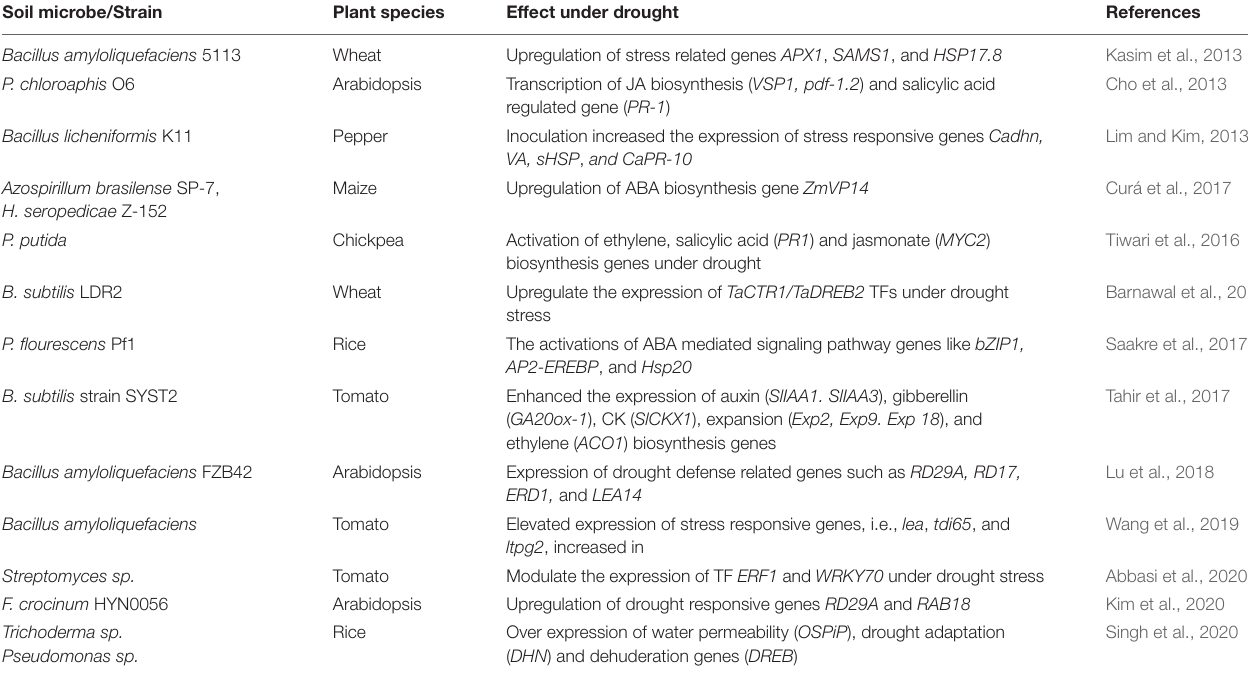
TABLE 9 | Upregulation of stress-responsive genes by PGPR under drought